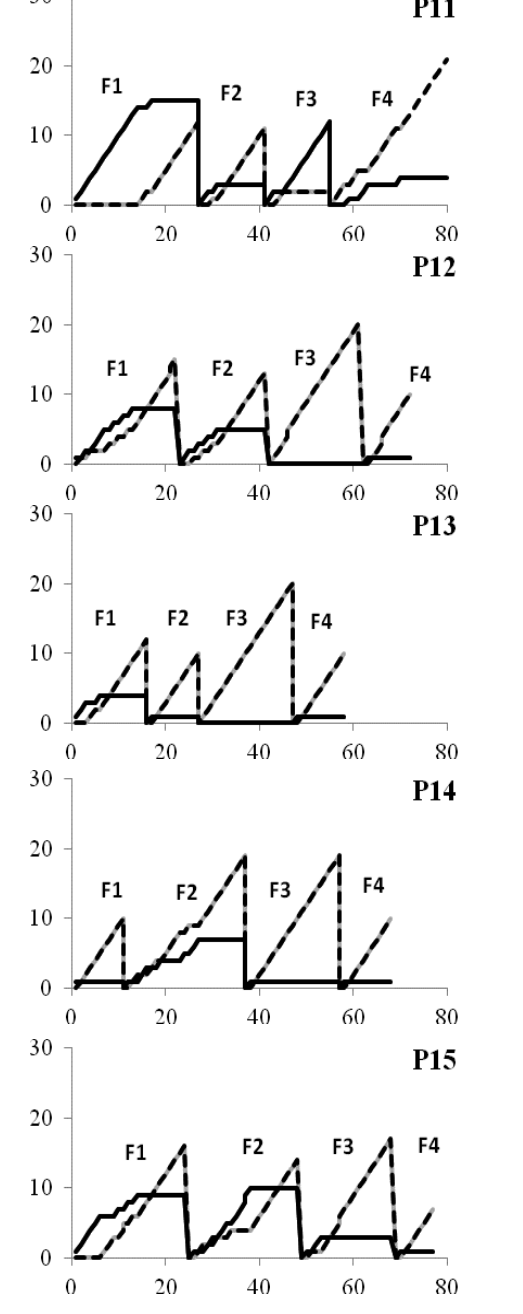
Figura 1. Frequência acumulada de respostas de seguimento de instrução (linha sólida) e de não seguimento de instrução (linha tracejada), para cada participante da Condição I, durante cada fase (F) experimental. Quebras na curva acumulada indicam mudanças de fase. Nas Fases 1, 2 e 4 eram apresentadas instru- ções discrepantes às contingências programadas para cada Fase, cujas respostas produziam perda de fi chas, enquanto que o não seguimento da instrução discrepante evitava perda de fi chas. Já na Fase 3 era apresentada uma instrução correspondente (que especi fi cava respostas que produziam perda de fi chas) com uma justi fi cativa social (ajudar os outros) para o seguimento da instrução correspondente.